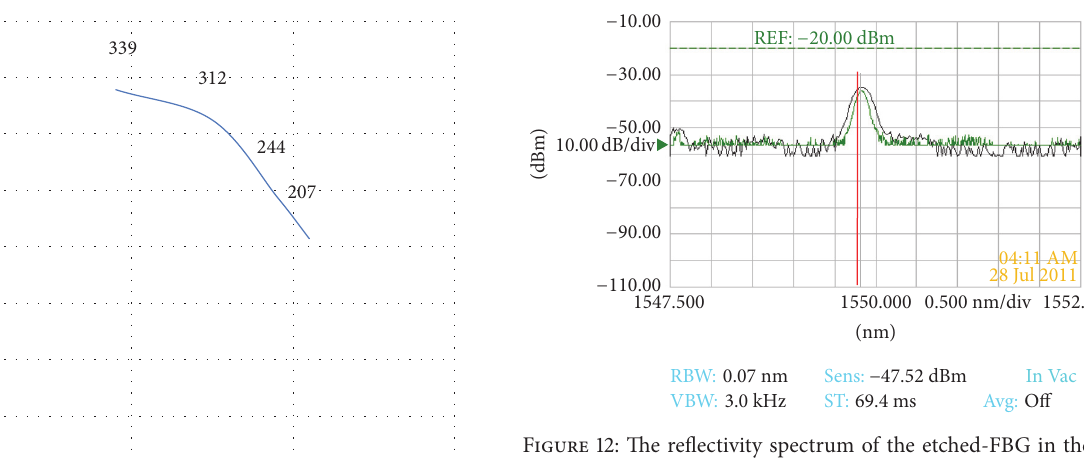
Figure 12: The reflectivity spectrum of the etched-FBG in the air (black line) and the reflectivity spectrum of the same FBG in the saline water (green line).